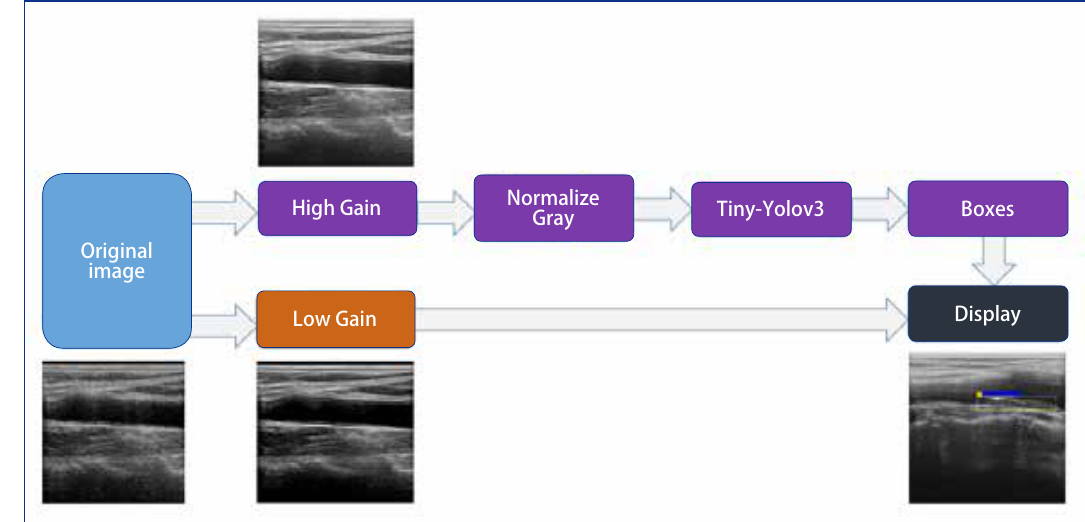
Figure 4 Image processing chain for Tiny-Yolov3